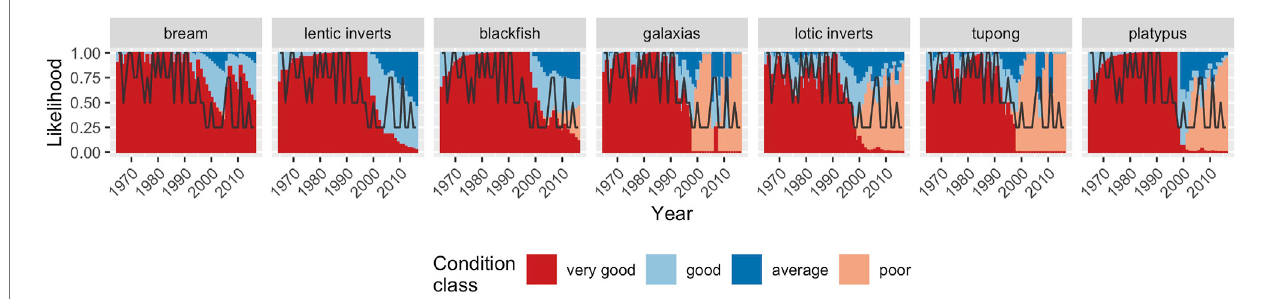
FIGURE4| Predictedconditionstates foreach population/communityfortheobserved fl owsequence from1990to2010.Theblack lineshowstherunoffclass in each year; 0.25 = “ Drought ” , 0.5 = “ Dry ” , 0.75 = Wet, and 1 = “ Very wet ” .